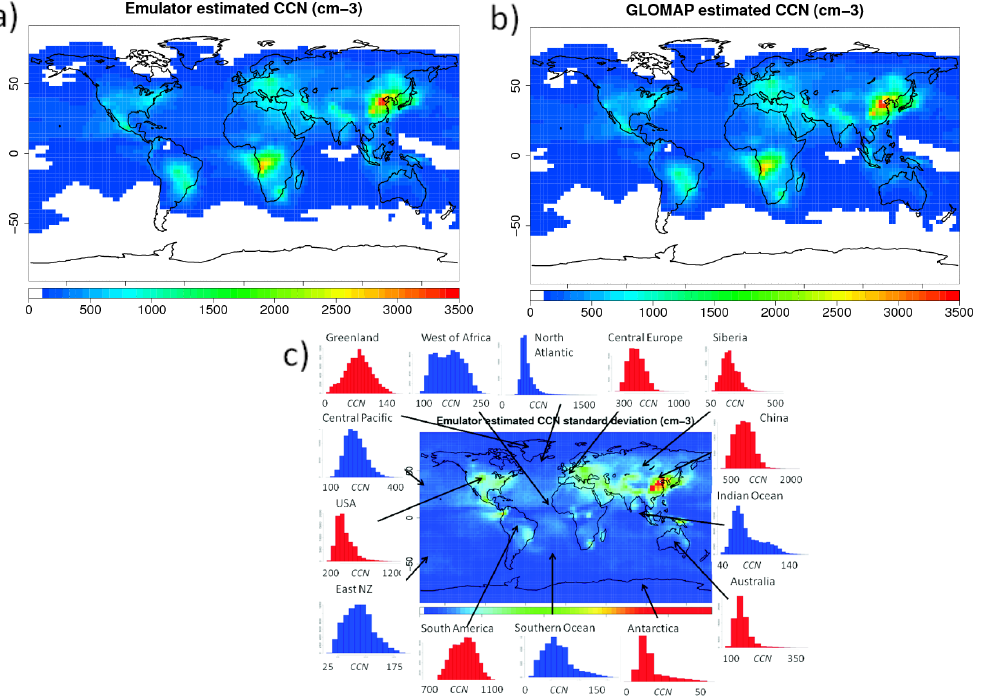
Fig. 2. Estimated July 2000 CCN from (a) the emulator and (b) the mean CCN from the 80 GLOMAP-mode runs. Panel (c) shows the uncertainty in the CCN (calculated as the standard deviation from the emulator) with posterior CCN distributions from the 80000 emulator simulations shown for 13